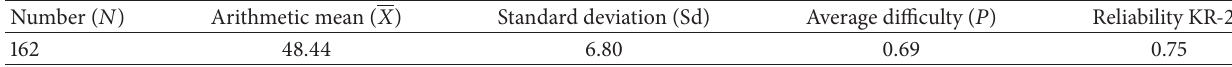
Table 2: Achievement test analysis results.